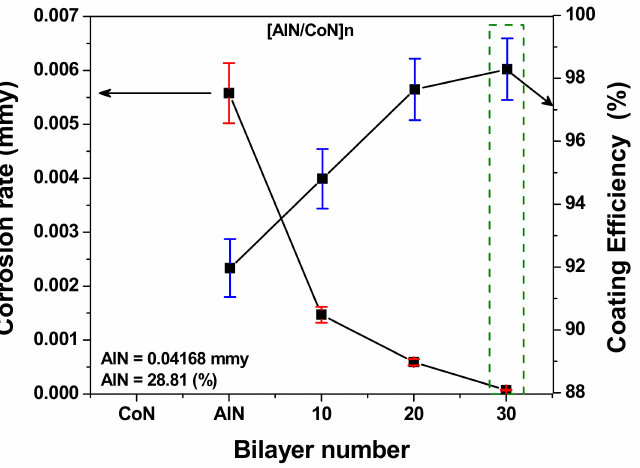
Figure 16. Correlation between corrosion rate and coating efficiency for the [AlN/CoN] n multilayer coatings deposited as a function of the increasing bilayer number